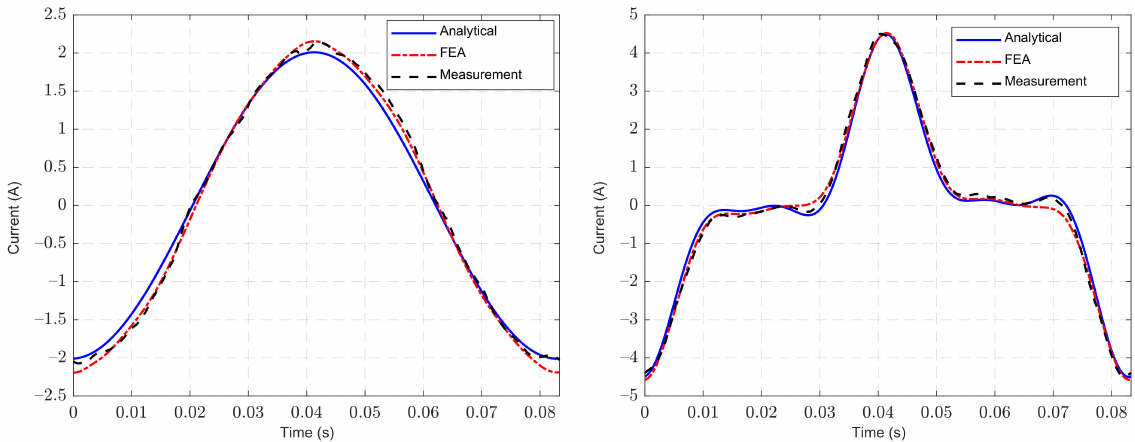
Figure 10. Current waveforms of single and higher order harmonic components injection obtained by analytical calculation, FEA, and measurement.